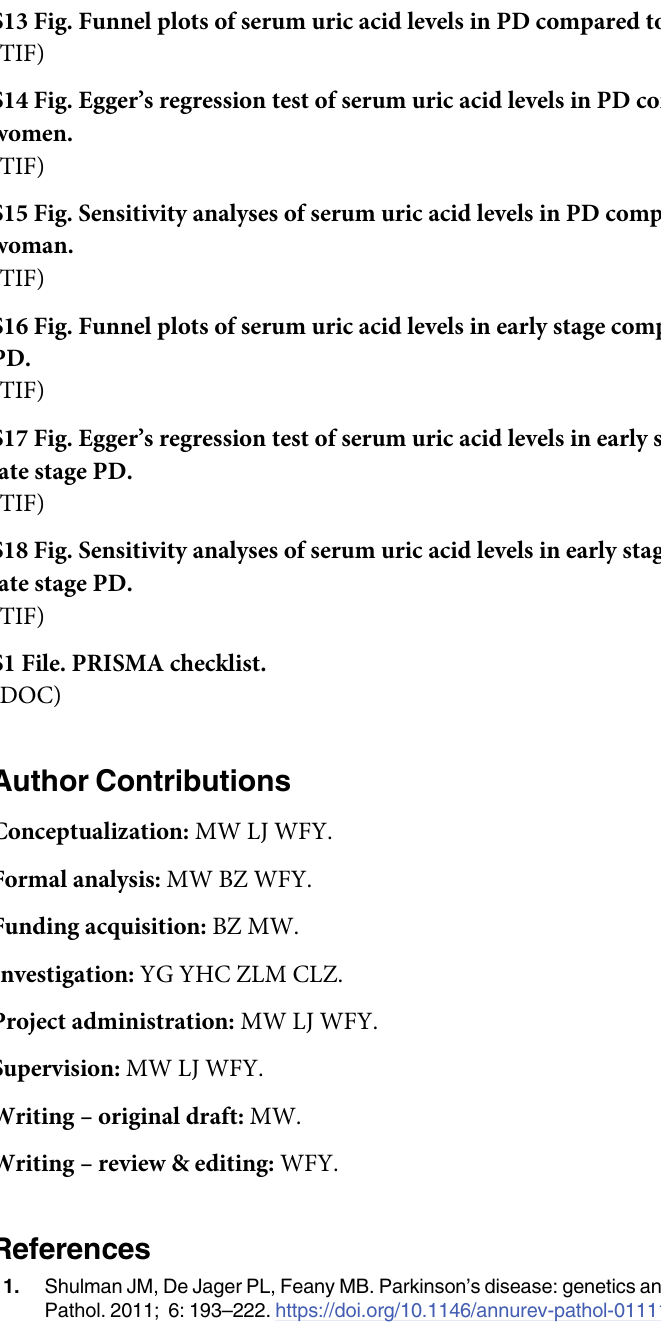
S10 Fig. Funnel plots of serum uric acid levels in PD compared to control in man. (TIF) S11 Fig. Egger’s regression test of serum uric acid levels in PD compared to control in man. (TIF) S12 Fig. Sensitivity analyses of serum uric acid levels in PD compared to control in man. (TIF) S13 Fig. Funnel plots of serum uric acid levels in PD compared to control in woman. (TIF) S14 Fig. Egger’s regression test of serum uric acid levels in PD compared to control in women. (TIF) S15 Fig. Sensitivity analyses of serum uric acid levels in PD compared to control in woman. (TIF) S16 Fig. Funnel plots of serum uric acid levels in early stage compared to middle-late stage PD. (TIF) S17 Fig. Egger’s regression test of serum uric acid levels in early stage compared to middle- late stage PD. (TIF) S18 Fig. Sensitivity analyses of serum uric acid levels in early stage compared to middle- late stage PD. (TIF) S1 File. PRISMA